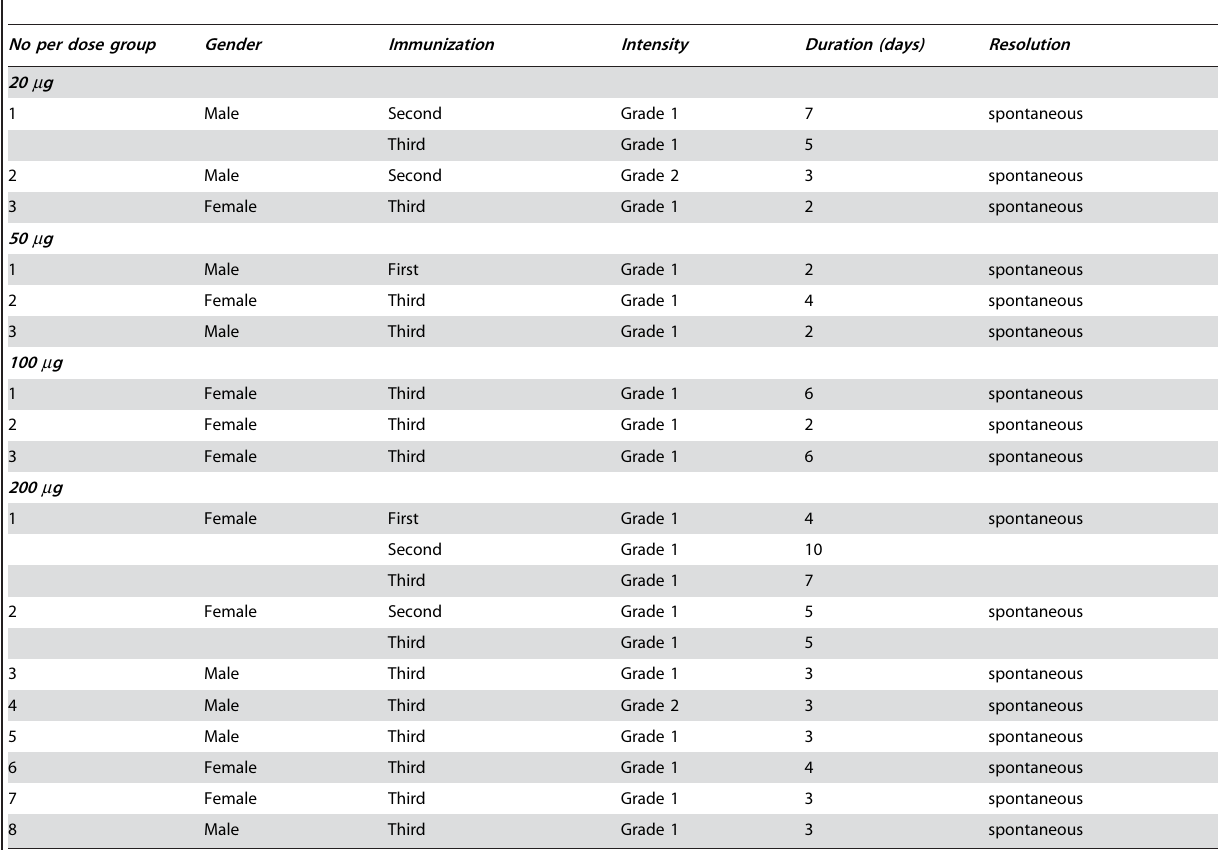
Table 3. Characteristics and evolution of swelling occurring following immunization occurring in the study.